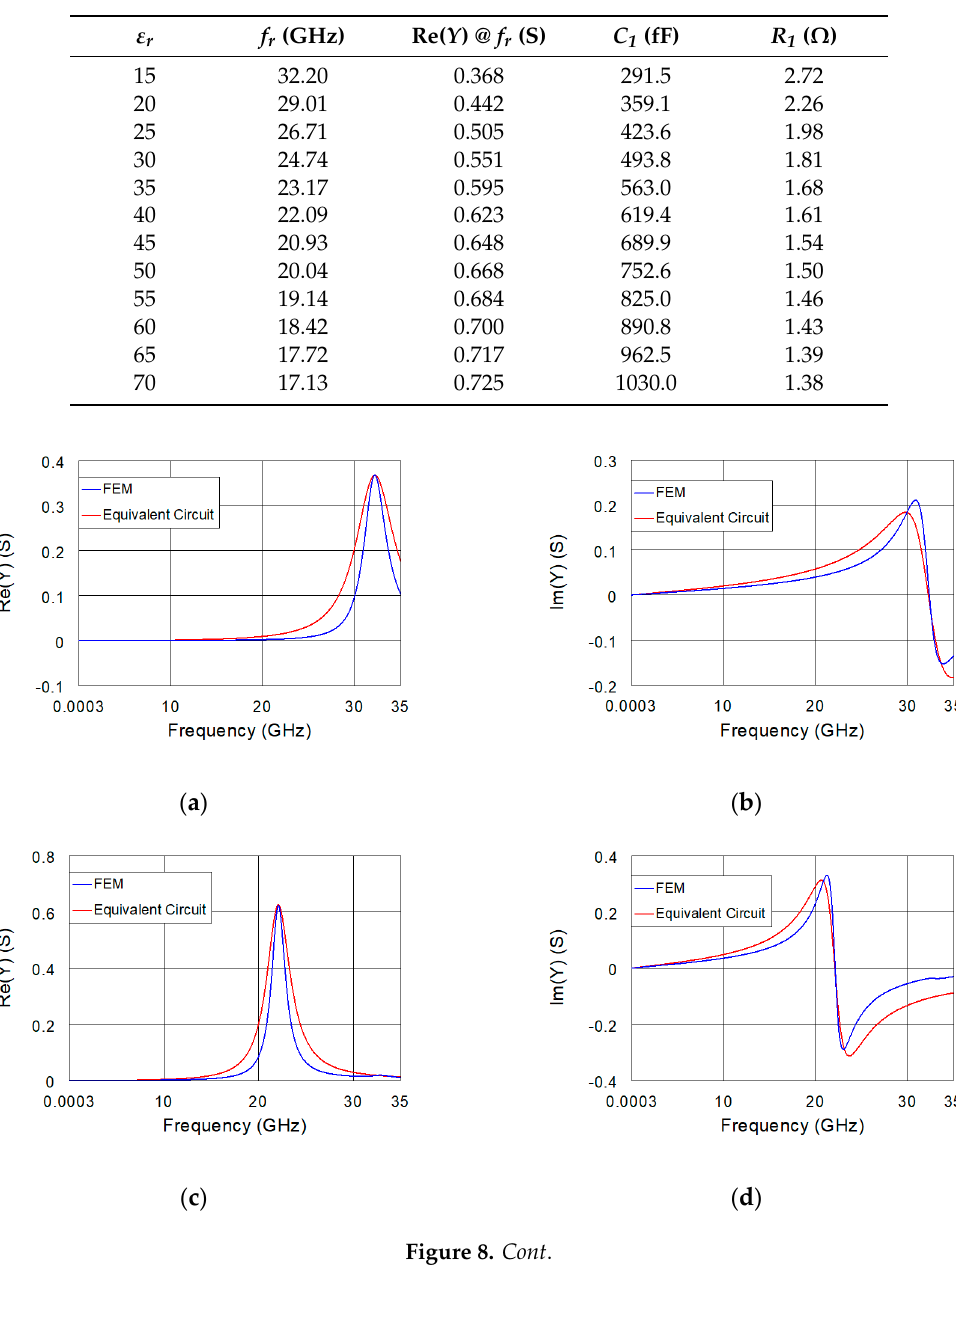
Table 2. Values of f r , Re( Y ) @ f r , C 1 , and R 1 as a function of ε r .